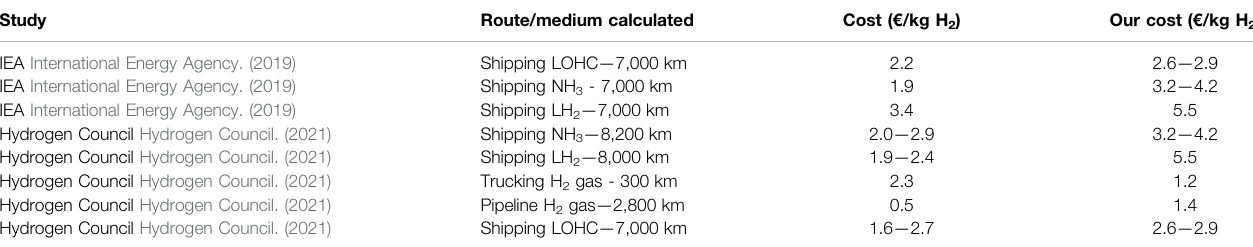
TABLE 5 | Comparison of H 2 transport costs of a variety of mediums and modes from similar